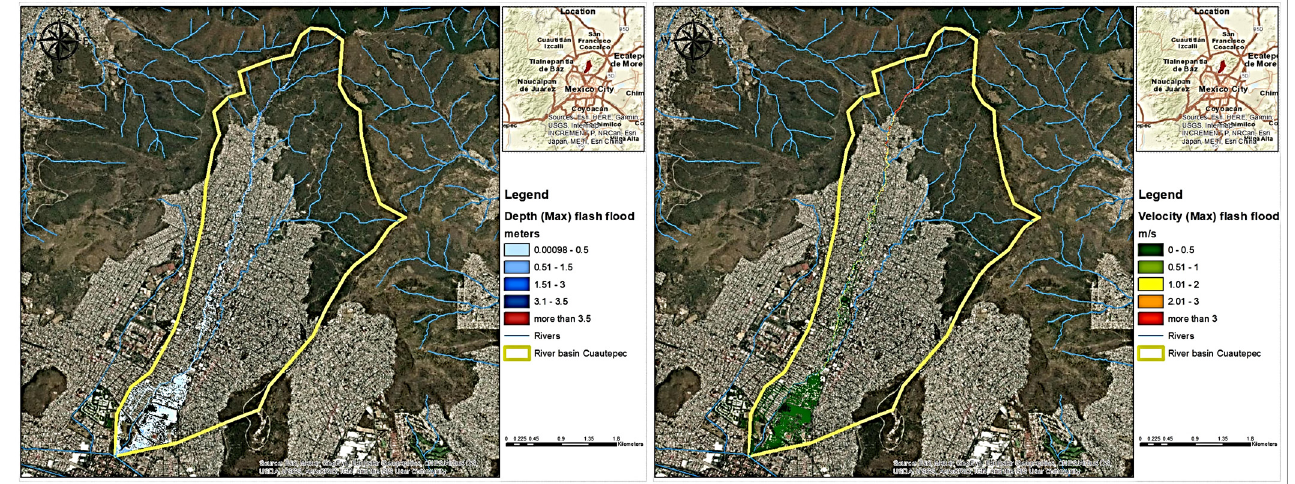
Figure 11. Depths and maximum velocity, maps for Historic flash flood using Hec ‐ Ras2d.